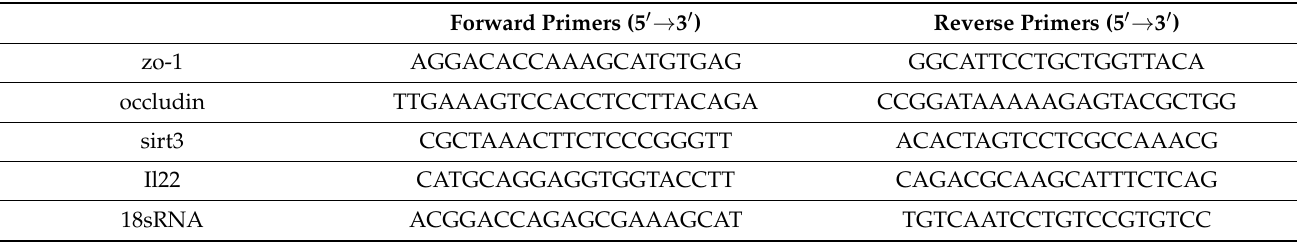
Table 1. Primers used in this